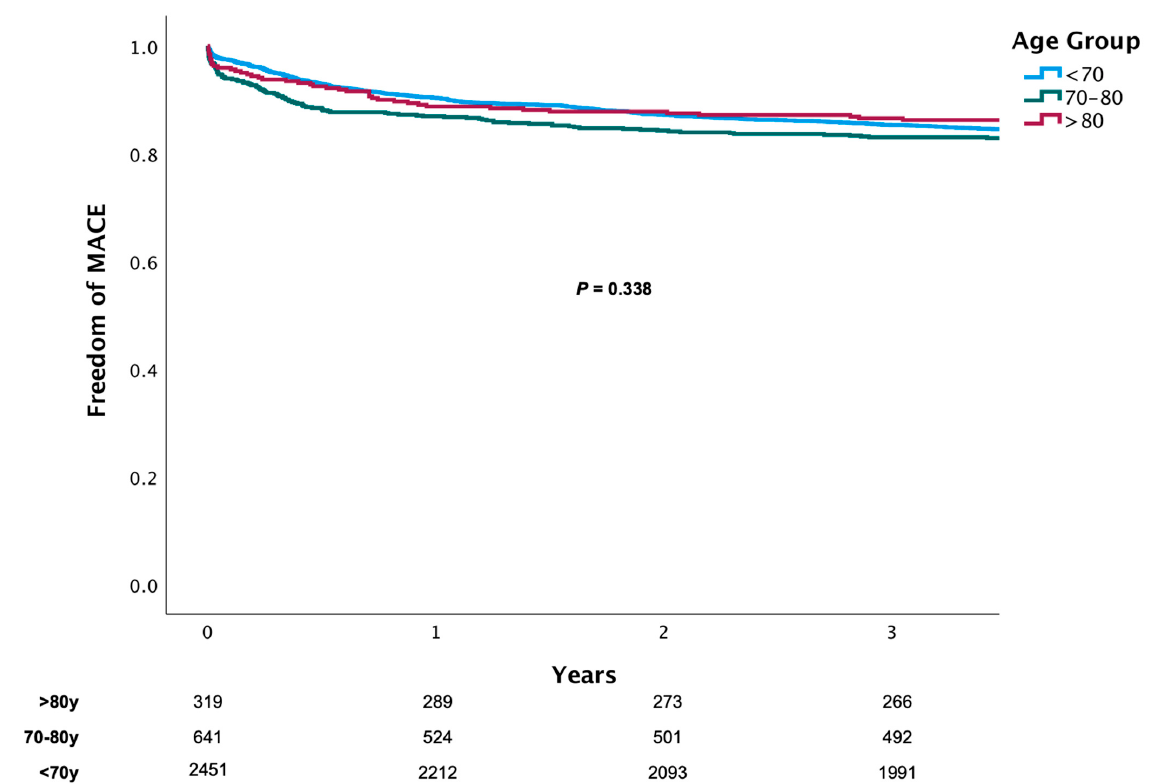
Figure 2. Kaplan–Meier curve of MACE according to age.